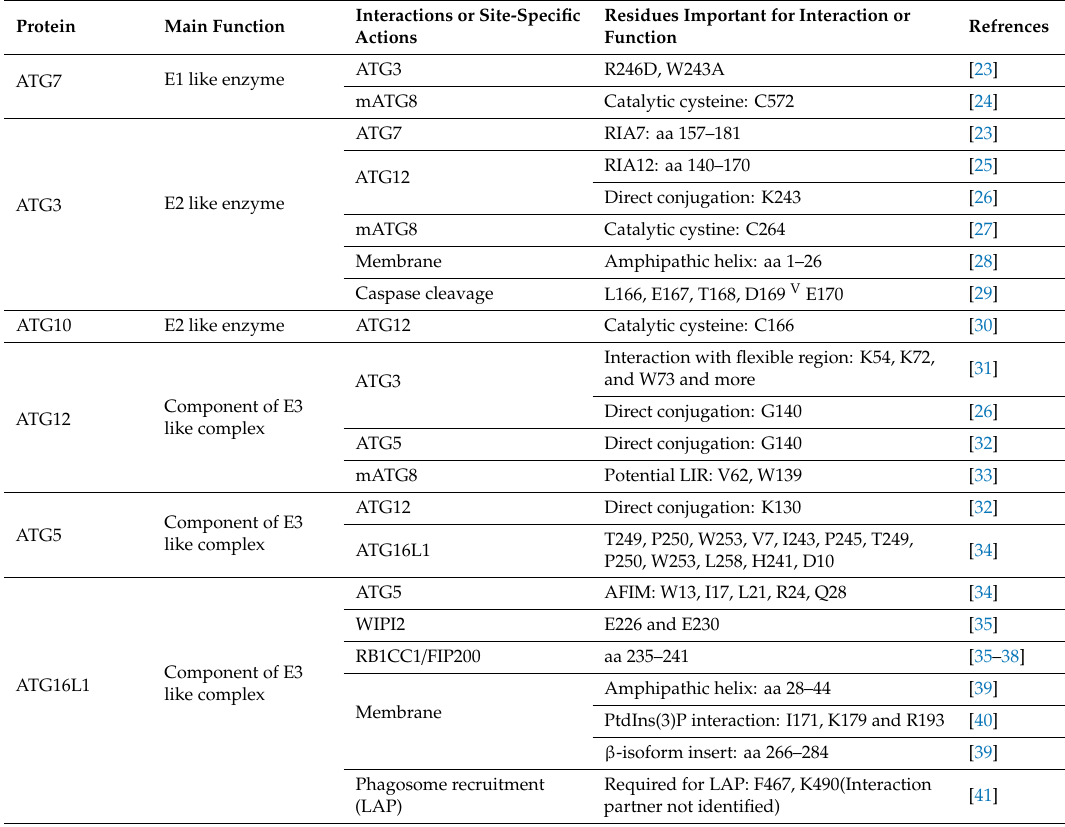
Table 1. Known interactions and functions of the core ATG8 conjugation machinery proteins during priming, lipidation / conjugation and